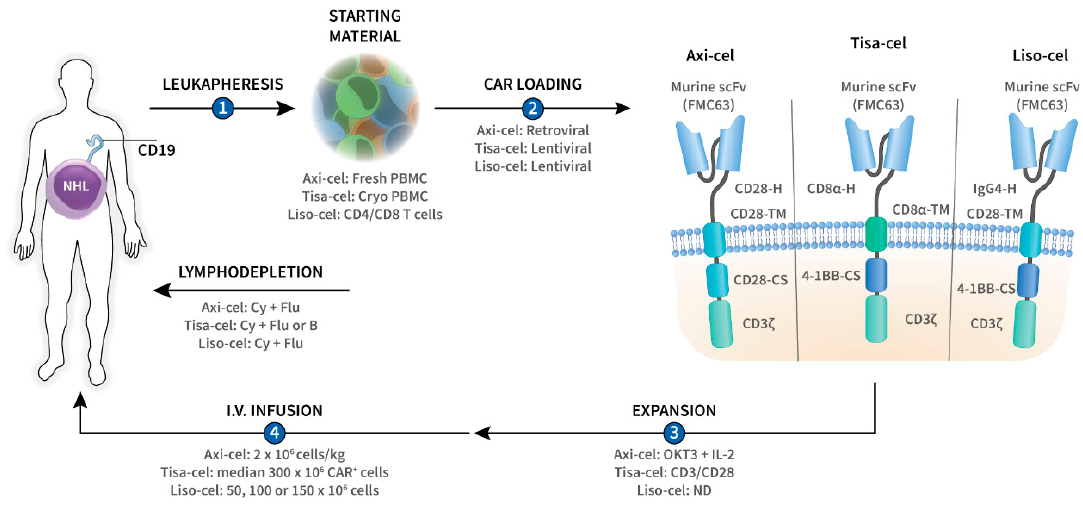
Figure 1. Overview of CD19-targeted chimeric antigen receptor (CAR)-T-cell therapies axicabtagene ciloleucel (axi-cel), tisagenlecleucel (tisa-cel), and lisocabtagene maraleucel (liso-cel) in CD19 + non-Hodgkin lymphoma (NHL). T cells are collected from the patient by leukapheresis ( 1 ) after which they are loaded with the CD19 CAR gene by means of lentiviral or retroviral transduction ( 2 ), and ex vivo expanded ( 3 ). The resultant CAR-T cells are then administered back to the patient by intravenous (i.v.) infusion ( 4 ). Lymphodepleting chemotherapy is usually administered prior to CAR-T-cell infusion in order to promote in vivo CAR-T-cell expansion and persistence. Axi-cel, tisa-cel, and liso-cel are second-generation CARs, of which the intracellular part contains the T-cell receptor ζ chain (CD3 ζ ) and a co-stimulatory (-CS) domain (CD28 or 4-1BB). The intracellular part is linked by the transmembrane domain (-TM) with the extracellular part of the CAR which is composed of the hinge and the antigen-recognition domain. The three constructs bear a different hinge (-H) but share the same murine FMC63-derived single chain variable fragment (scFv) as antigen-binding domain. B, bendamustine; CD3 / CD28, anti-CD3 / CD28 microbeads; Cy, cyclophosphamide; Flu, fludarabine; IL-2, interleukin-2; ND, no data; OKT3, anti-CD3 monoclonal antibody; PBMC, peripheral blood mononuclear cells.